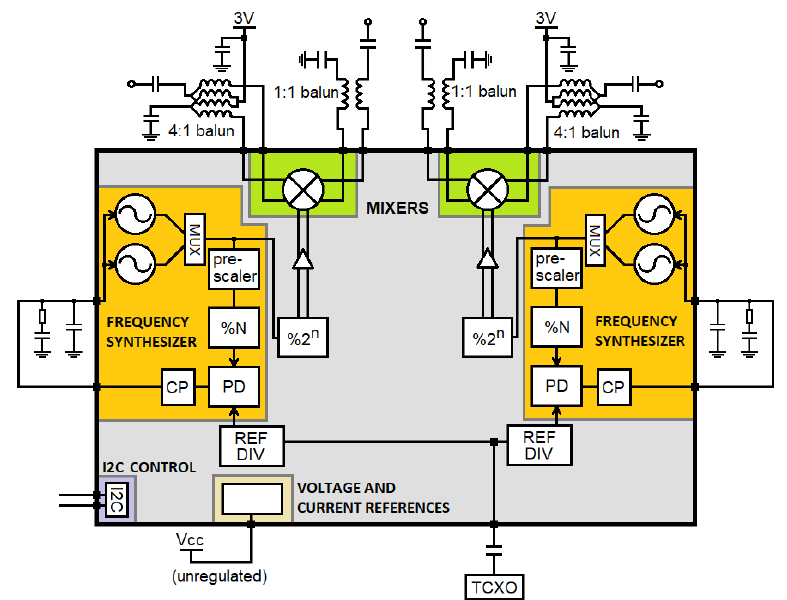
Figure 4. Block diagram of the reconfigurable RF converter RFID-II, formed by two variable frequency synthesizers, two passive mixers, and auxiliary